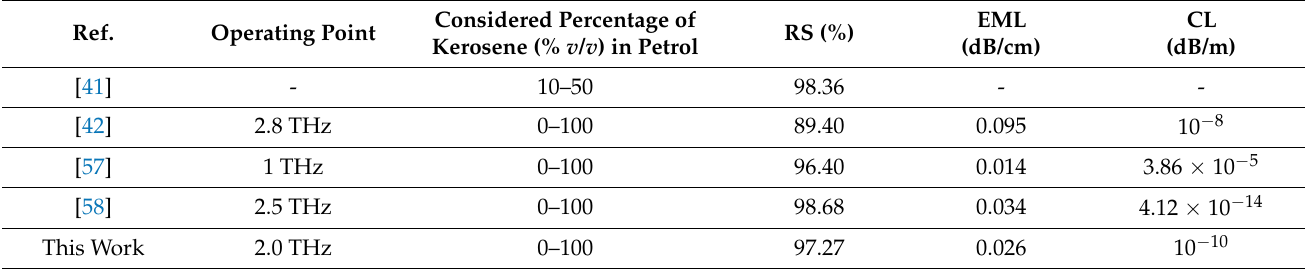
Table 4. Result comparison with other prior fuel adulteration